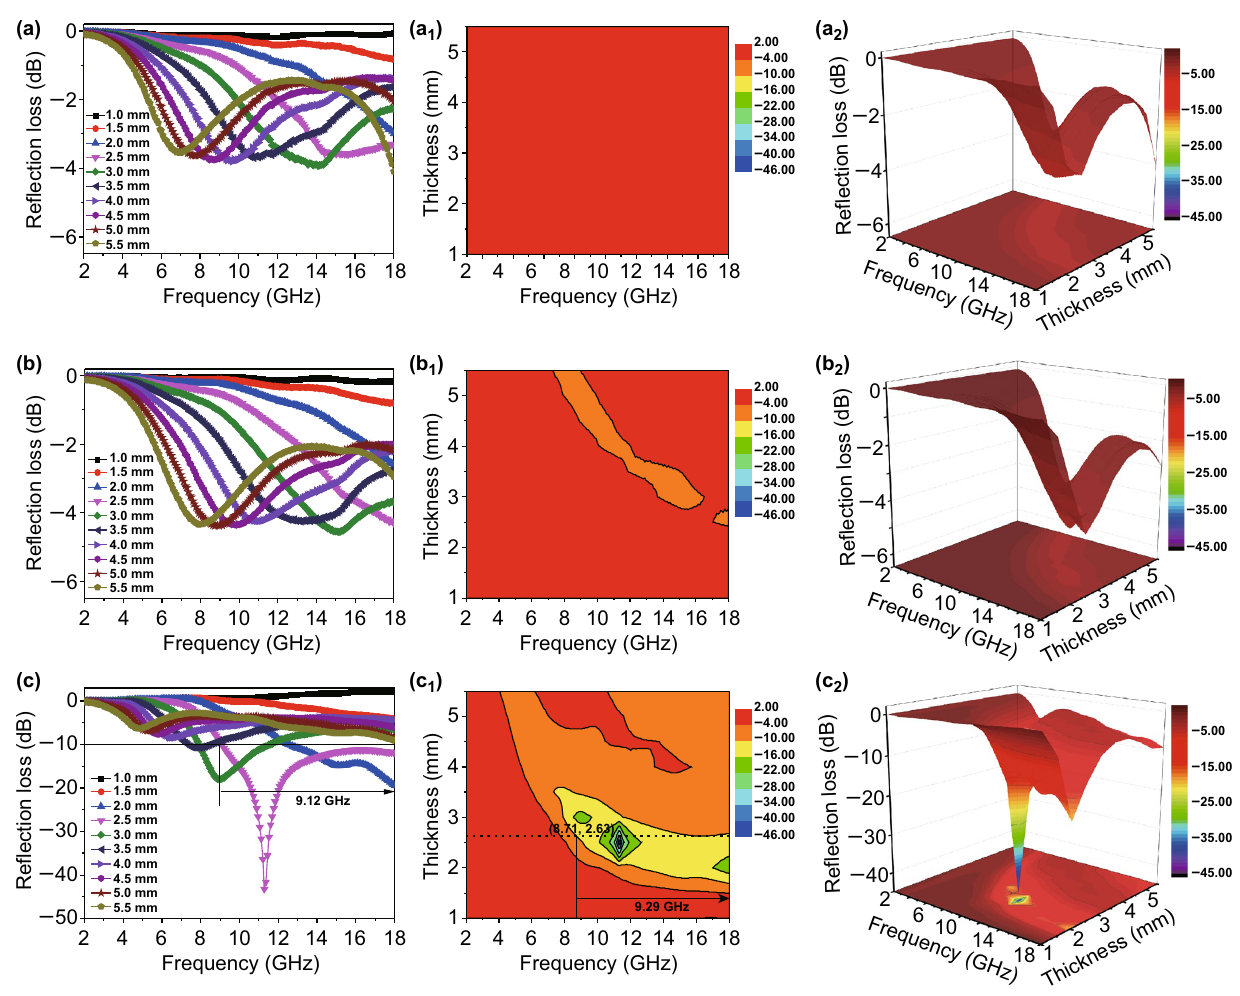
Fig. 9 Calculated 2D/3D reflection loss of Co/NC ( a , a 2 ), Fe–Co/NC ( b , b 2 ), Fe–Co/NC/rGO ( c , c 2 ) and contour maps of the reflection loss of Co/NC ( a 1 ), Fe–Co/NC ( b 1 ), and Fe–Co/NC/rGO ( c 1 ) with the mass filling ratio of 25